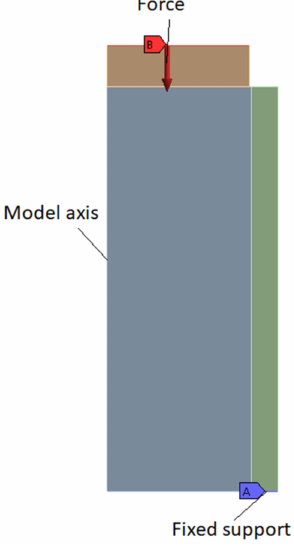
Figure 7. Model with boundary conditions and